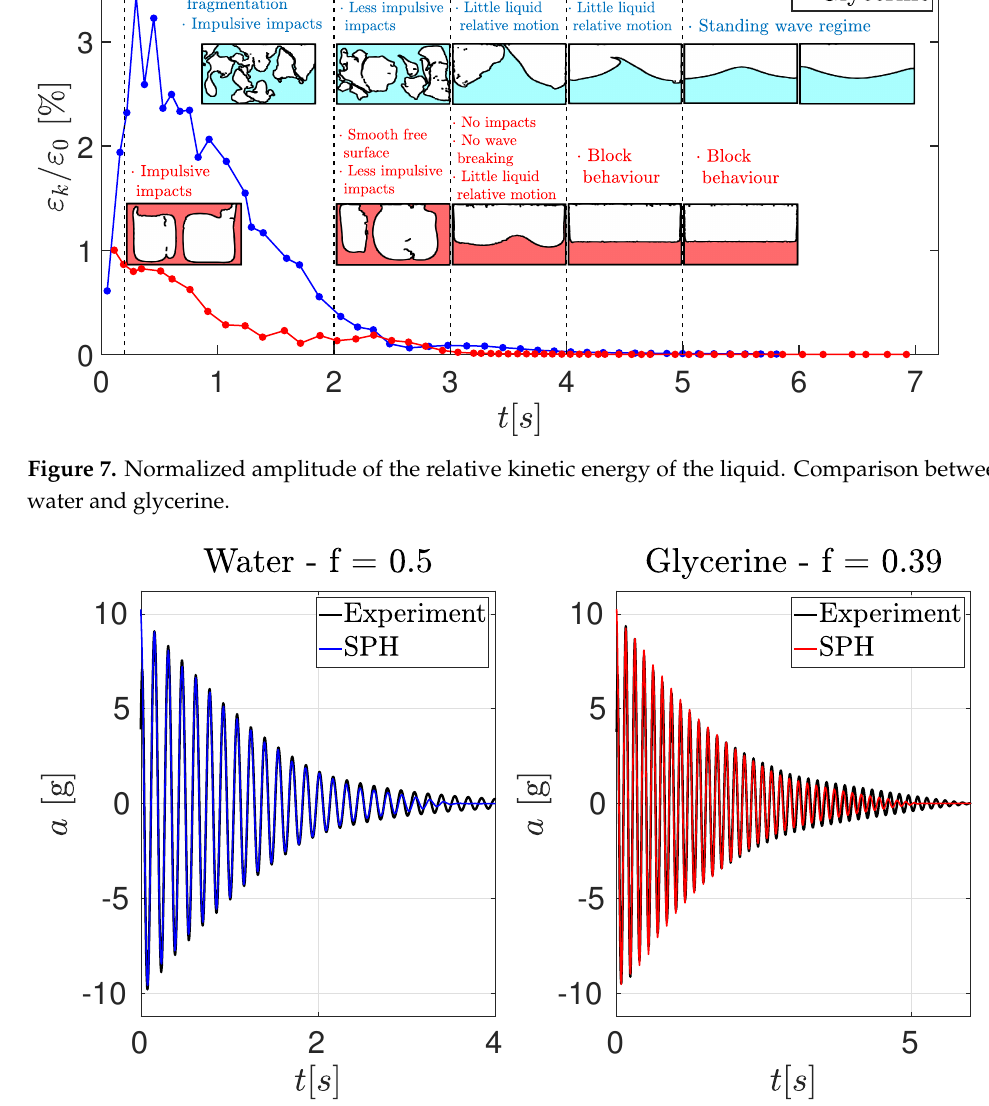
Figure 8. Comparison between δ -SPH simulations and experimental data of the acceleration of the tank over time for water and glycerine decay tests at 10 g of maximum